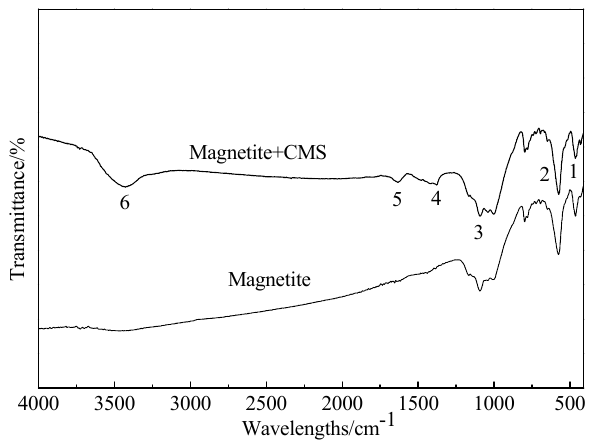
Figure 12. Infrared spectral analysis.